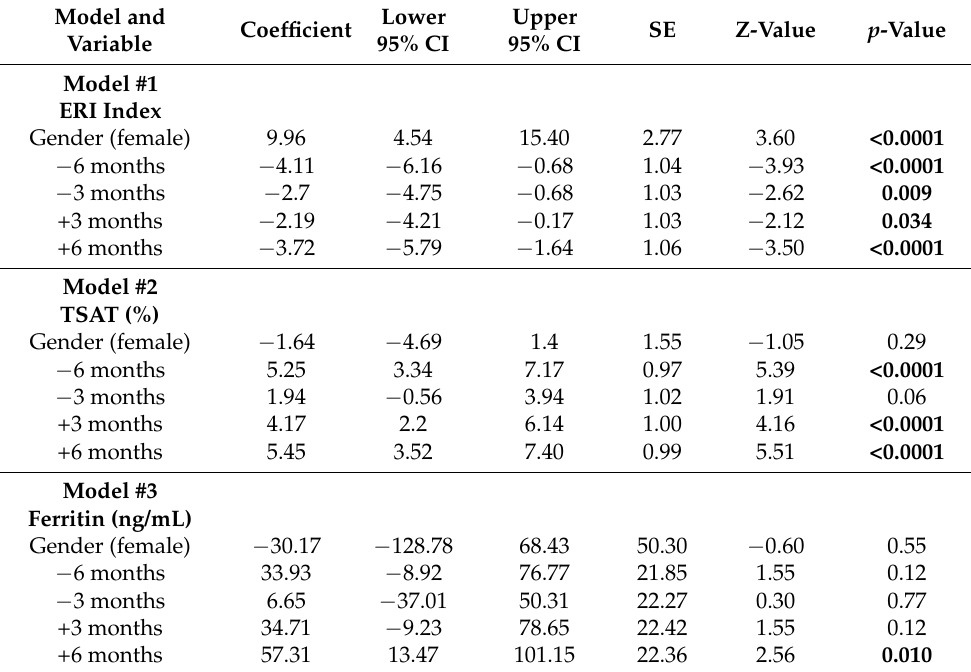
Table 2. Mixed models to explore the association between different variables pre- and post-FCM switch. Model